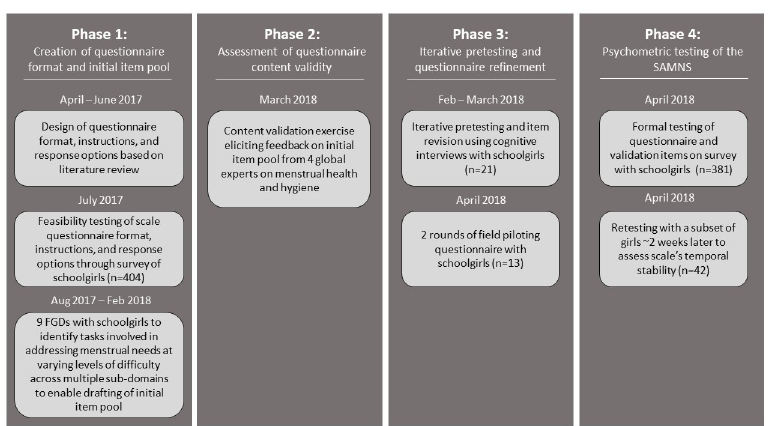
Fig 1. Process of development and testing of the Self-Efficacy in Addressing Menstrual Needs Scale in 8 urban and rural schools in Bangladesh 2017–2018.